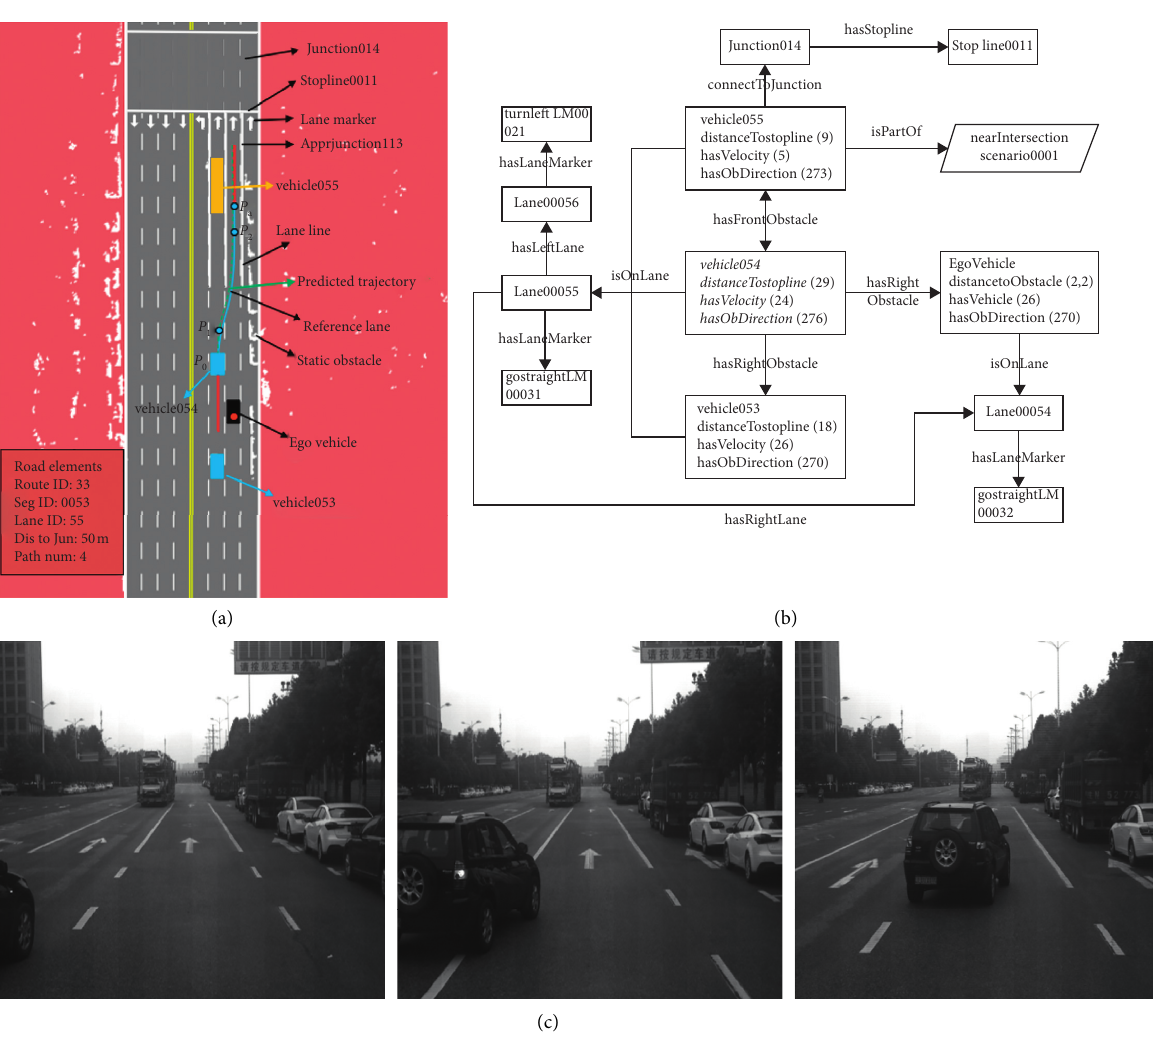
Figure 19: The results of Scenario 1: (a) trajectory prediction interface; (b) scenario reasoning; (c) experimental